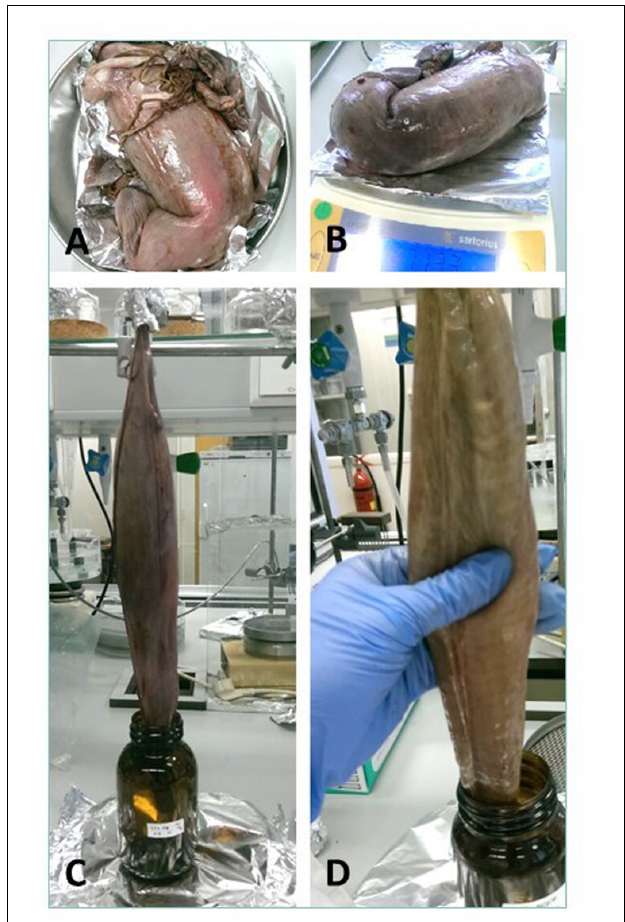
FIGURE 5 | The chosen method and different steps to remove spiral valve content. (A) Thawing, (B) Weighing, (C) Hanging, (D)